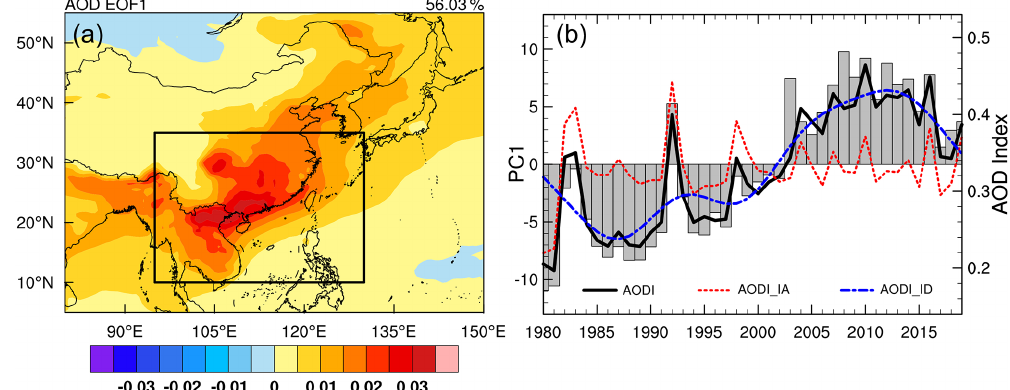
Figure 2. (a) Spatial pattern (shading) and (a) principal component (grey bars) of the first EOF mode of MAM mean AOD over East Asia during 1980–2019. The East Asian spring AOD index (AODI; solid black line), defined as AOD averaged over East Asia (10–35 ◦ N, 95– 130 ◦ E; the black box in a ), is also plotted in (b) , together with its interannual component (AODI_IA; dashed red line) and interdecadal component (AODI_ID; dashed blue line).